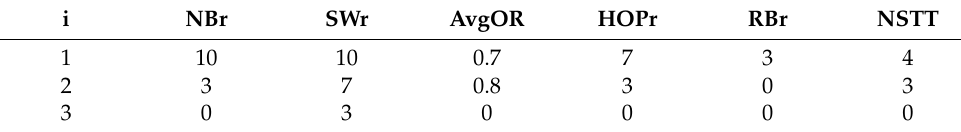
Table 2. Application example of the imbrical spreading function where (NB, SW) = (10,